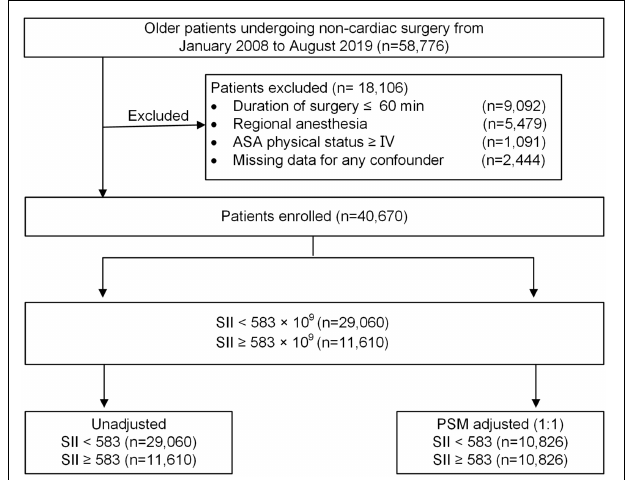
FIGURE 1 | Study profile. ASA, American Society of Anesthesiologists; PSM, propensity score matching.